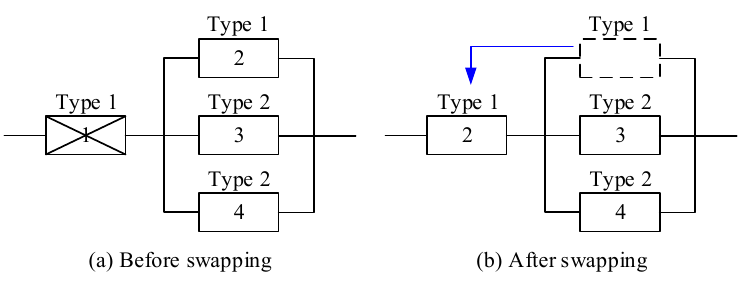
Figure 4. Illustration of component swapping.